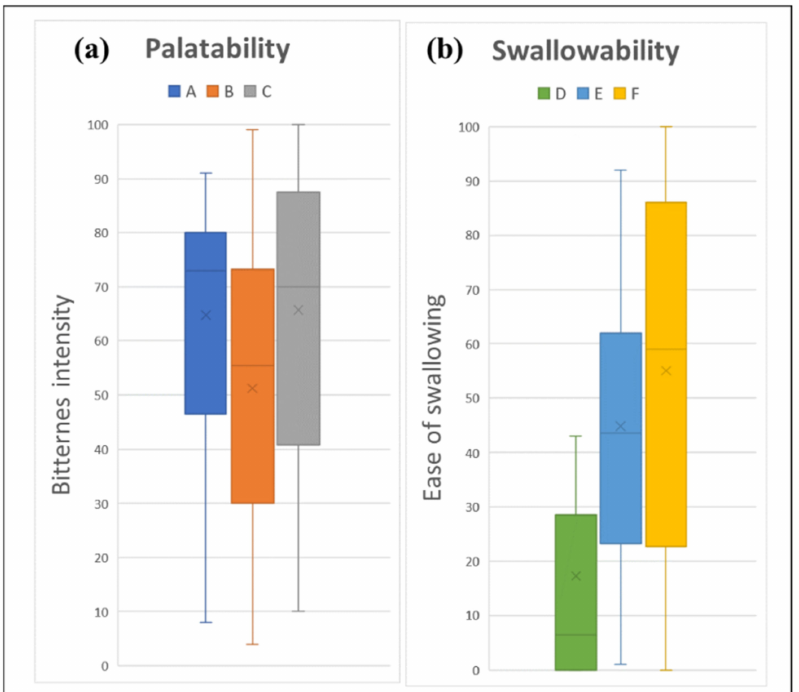
Figure 3. Sensory assessment of fluid gel: ( a ) palatability assessment; and ( b ) swallowability assess- ment, where 0 is “None” and 100 is “Strong bitterness” for palatability assessment, and 0 is “Very easy” and 100 is “Very difficult” for swallowability assessment. Fluid gels formulated with different consistency were assigned as samples A and D (thin liquid), B and E (mildly thickened liquid), and C and F (highly thickened liquid).